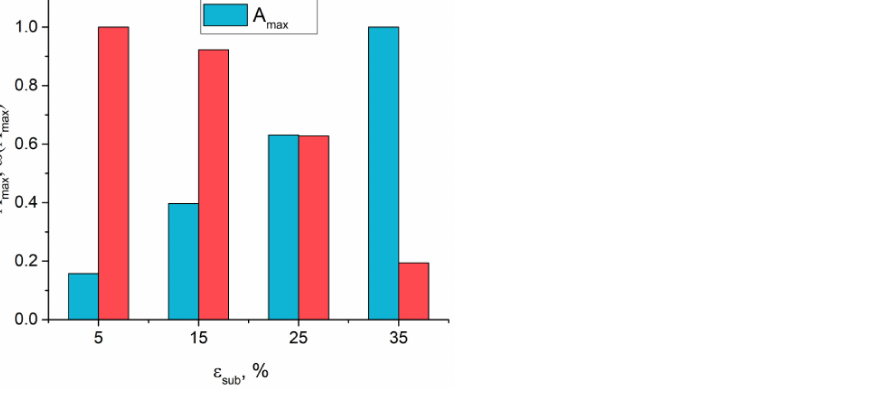
Figure 9. Normalized amplitude-frequency characteristics for the maximum-amplitude FFT compo- nents for different strains.